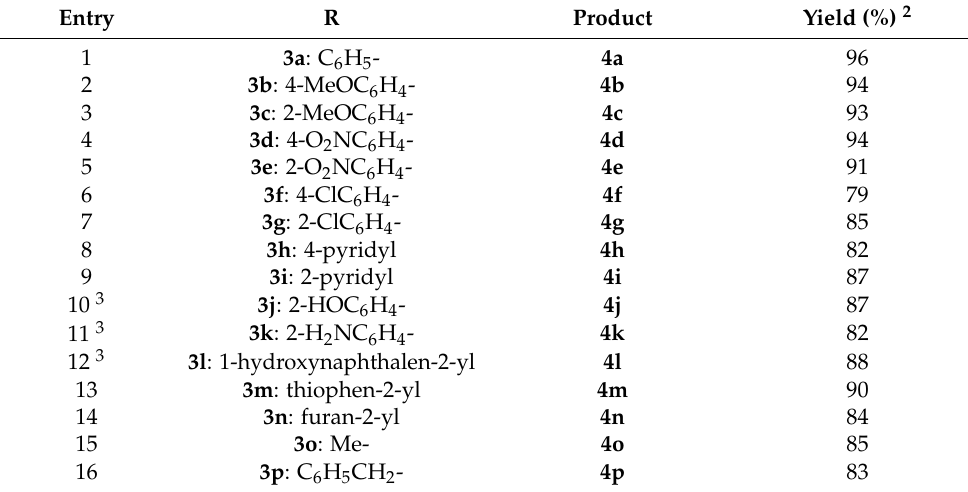
Table 2. Isomerizations of various amides in the presence of Cu(OTf) 2 1 .